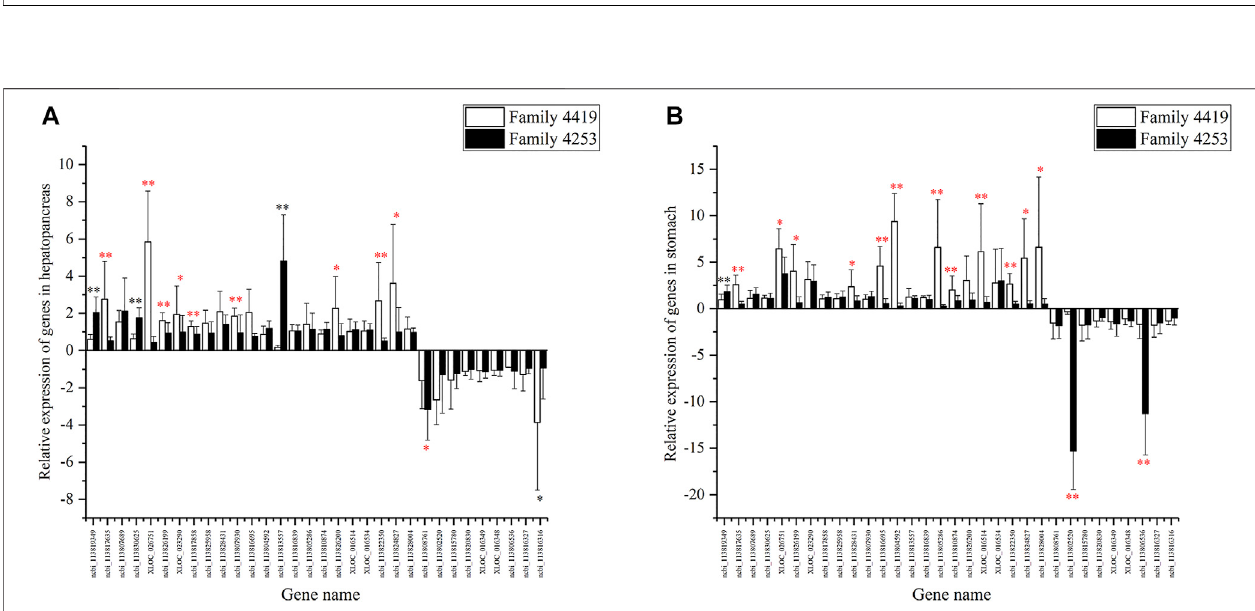
FIGURE6| Geneset enrichmentanalysis(GSEA) ofKyoto Encyclopedia ofGenesand Genomes (KEGG)subset ofcanonical pathways. (A) Themost signi fi cantly enrichedpathwayinresistantfamilies. (B) Themostsigni fi cantlyenrichedpathwayinsusceptiblefamilies.R,resistantsamples;S,susceptiblesamples.Nominal p -value, false discovery rate (FDR), enrichment score (ES), and normalized ES were determined by the GSEA software and were indicated within each enrichment plot.